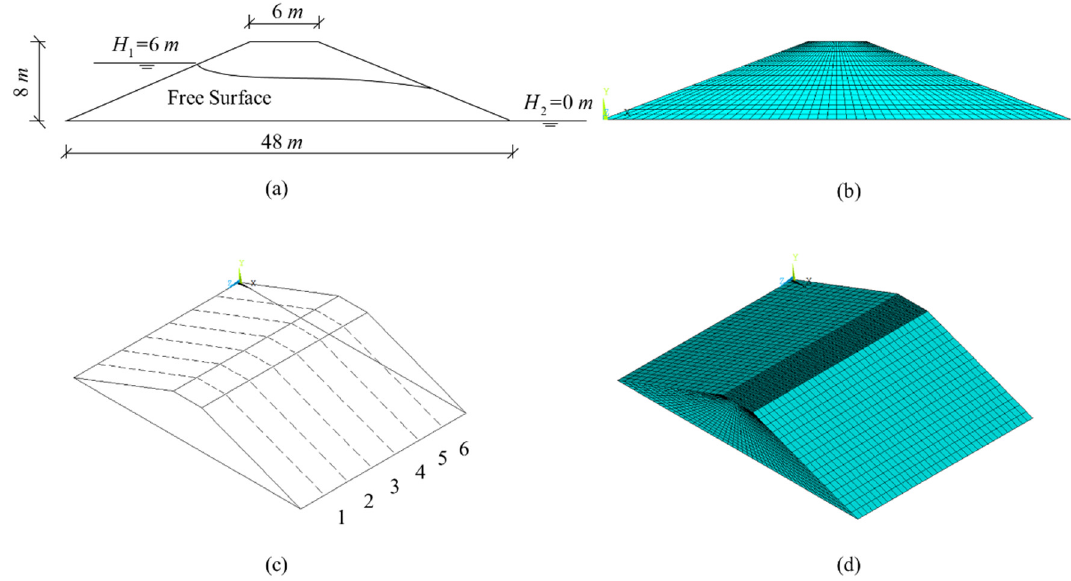
Figure 3. Embankment model of Shijiu Lake: ( a ) dimensions of section; ( b ) mesh generation of section; ( c ) location of section in embankment model; ( d ) mesh generation of embankment.